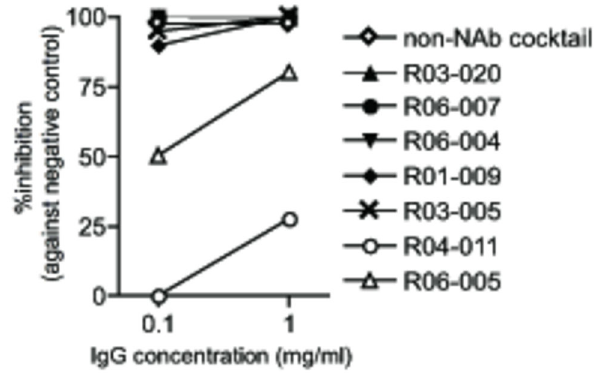
Figure 3. ADCVI activity of the non-NAb cocktail and non- NAb IgG lots. The reduction in SIV p27 concentration in the supernatant from SIV-infected cell culture with non-NAbs compared to that without antibodies is shown. A representative result, means of duplicate samples, from two experiments is shown. doi: